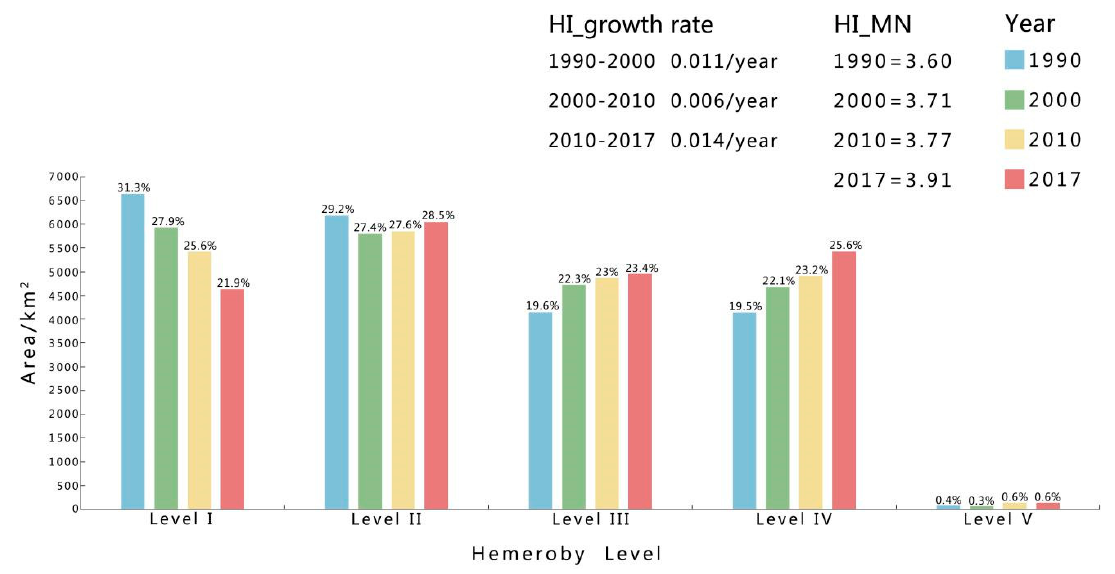
Figure 4. Area variation of different hemeroby levels.